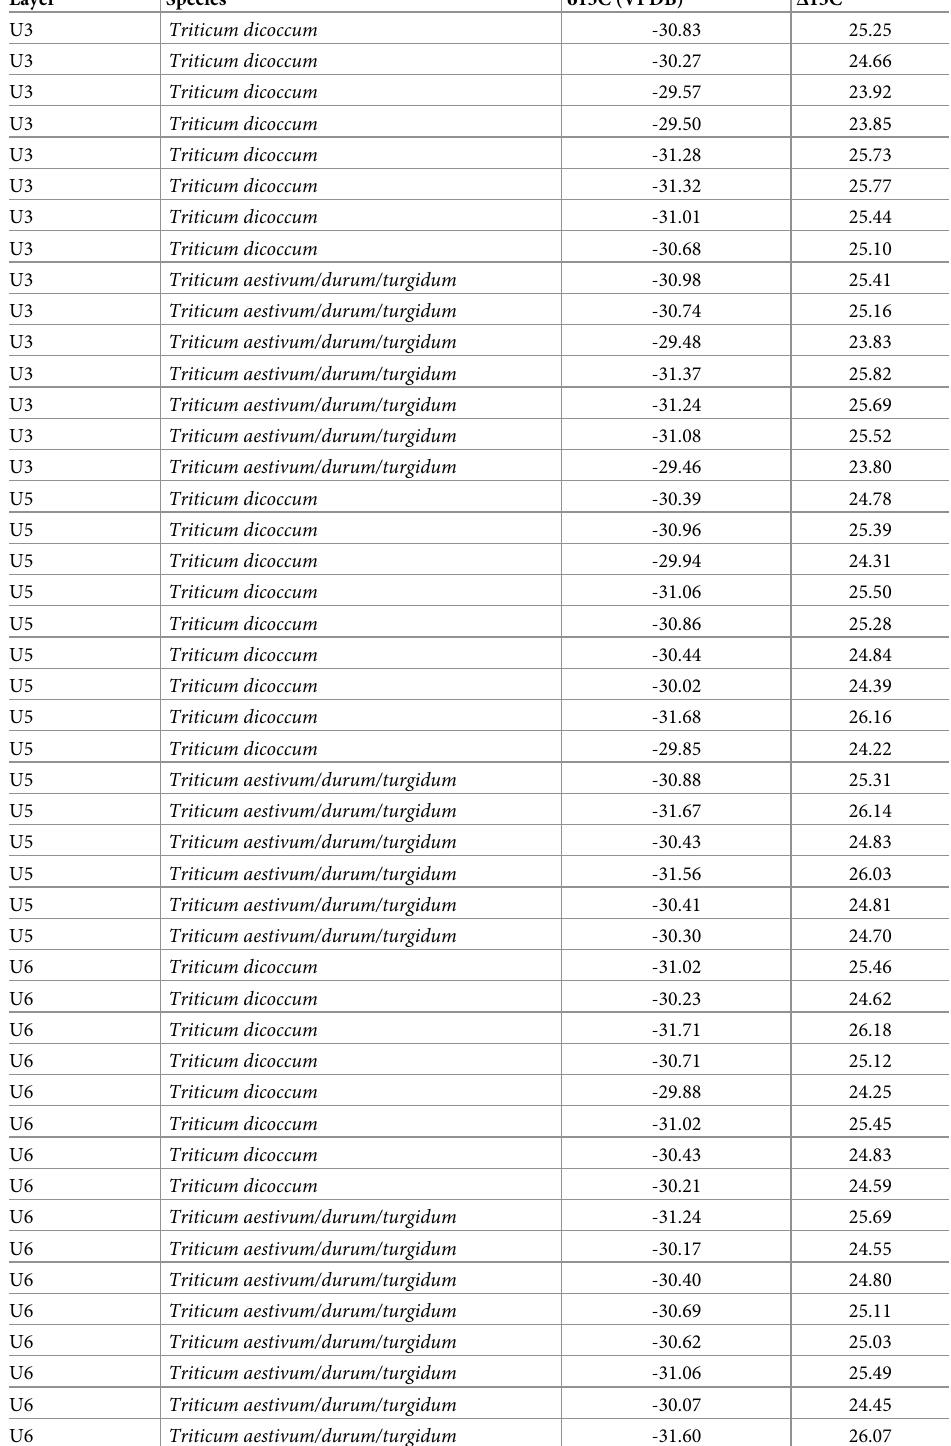
Table 4. Δ 13 C values of uncharred chaff samples from units 3, 5, 6 and 8 dated to the Late Neolithic (Horgen